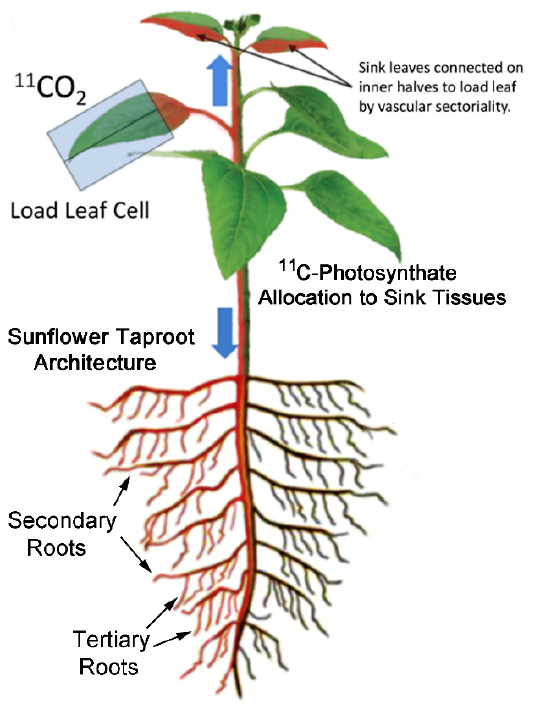
Figure 1. Experimental setup showing patterns of 11 C-allocation. 11 CO 2 was administered to a single source leaf encased in a gas tight cell. Export 11 C-photosynthates to sink tissues (i.e., young leaves and roots) is shown in red with direct connections to only half of two younger sink leaves attached immediately above that source leaf and half the root system.